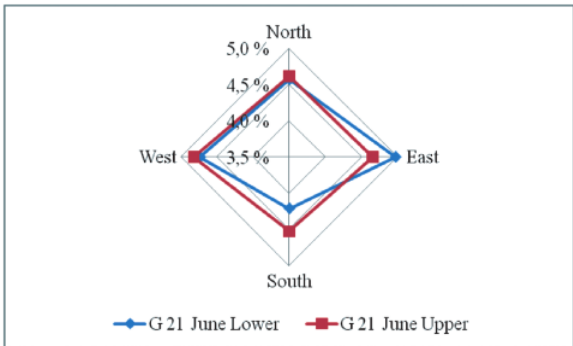
Fig. 13: Stone-pulp ratio in the function of orientation and height in the case of Germersdorfi [%]